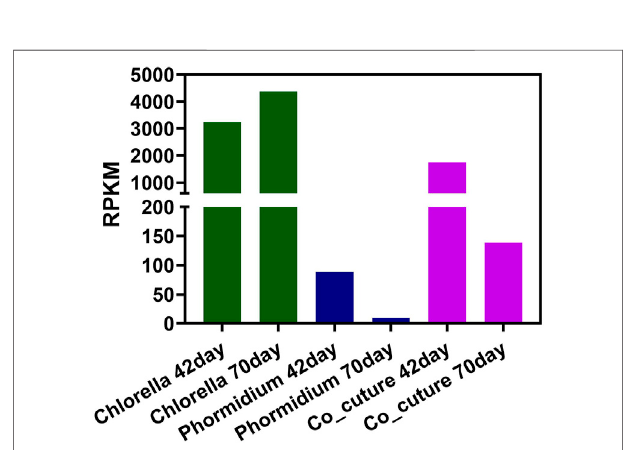
FIGURE 6 | Gene abundance of algal cyclin in all